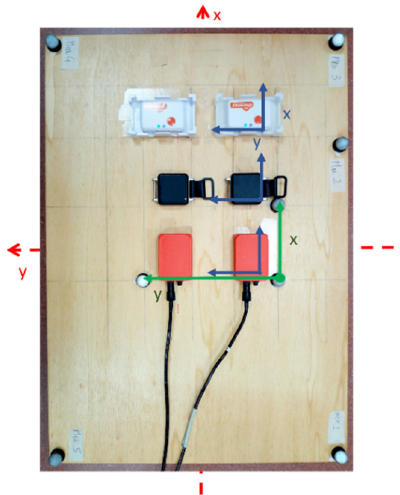
Figure 1. Board equipped with six magneto-inertial measurement units (MIMUs) (relevant local coordinate system (LCS) in blue) and the eight reflective markers. The three central markers were used to define the stereo-photogrammetric (SP) system LCS (in green). Board axes (in red) are coincident with MIMUs and SP system LCSs. Reprinted with permission from ref. [31]. Copyright 2020 IEEE.